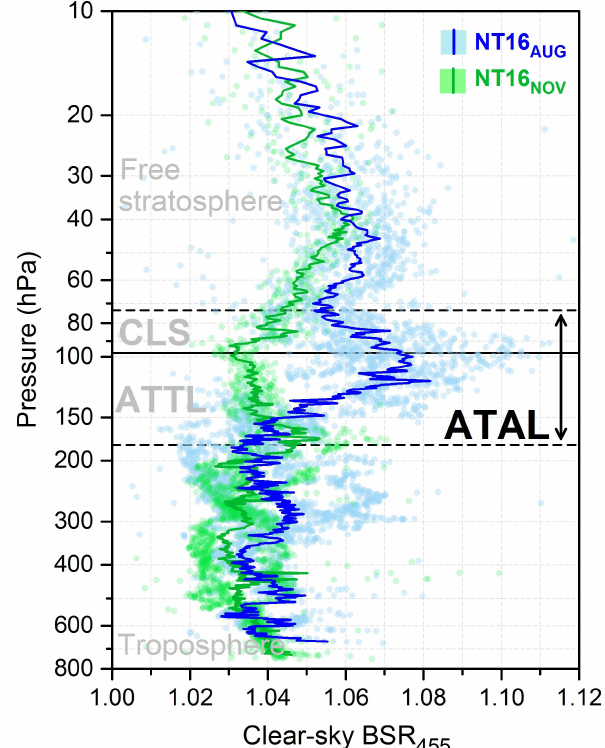
Figure 11. All clear-sky (i.e., aerosol only) data points (dots) and mean profiles (solid lines) of BSR 455 as a function of pressure, for NT16 AUG (blue) and NT16 NOV (green). Black lines show the mean LRM (dashed), CPT (solid) and TOC (dashed) levels for NT16 AUG . The troposphere, ATTL, CLS and free stratosphere regions are iden- tified using grey labels, and the ATAL region is identified using a black